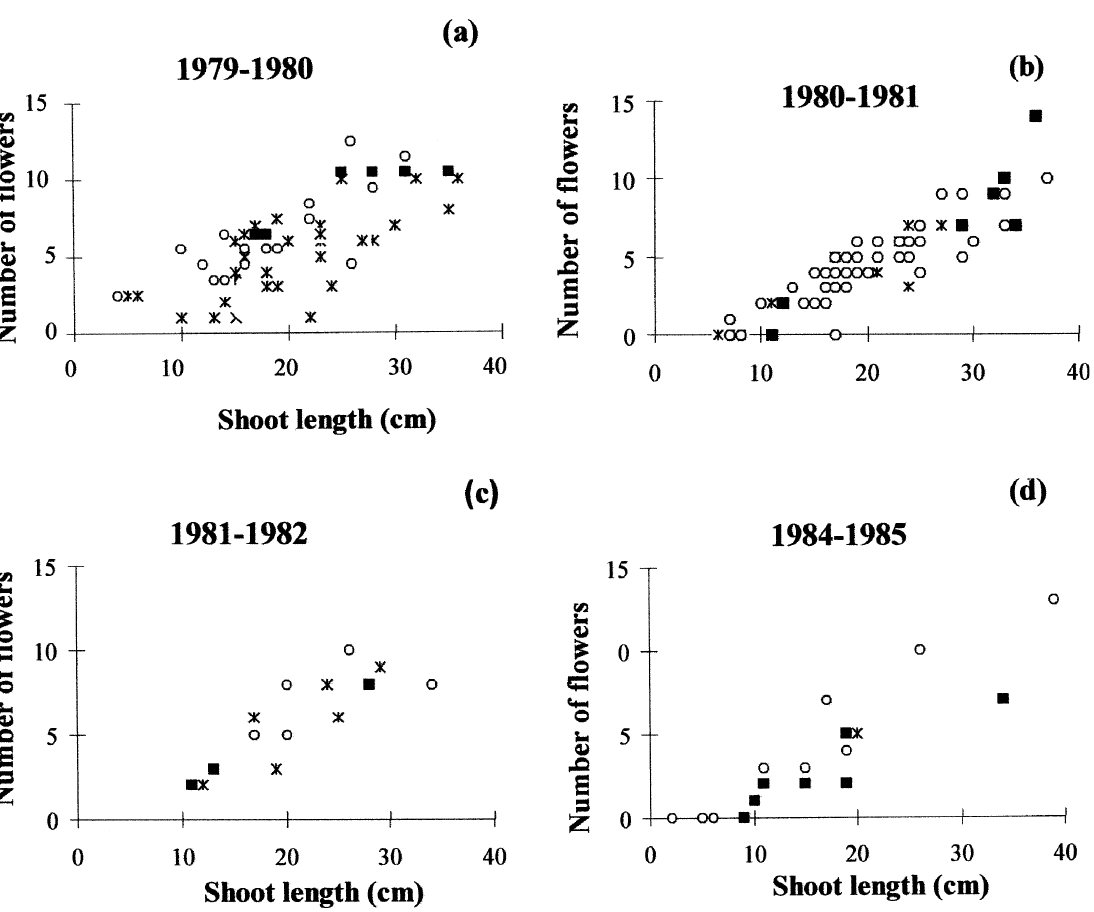
Fig. 1. Shoot length in cm and number of flowers in all Epipactis albensis plants that first appeared in 1979 (a), 1980 (b), 1981 (c) and 1984 (d), with indication of their performance in the subsequent year. x : flowering, ■ : sterile, (cid:1) :